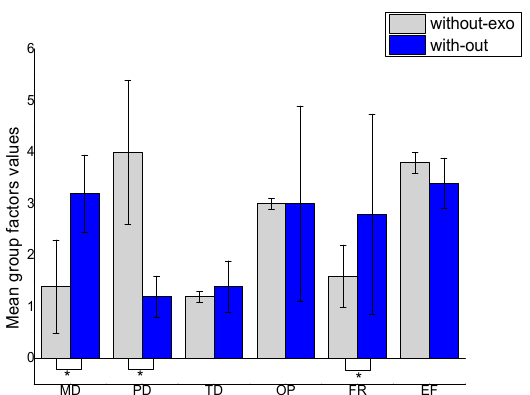
( b ) Figure 10. ( a ) The subjective discomfort performance. ( b ) The comparisons of mean rating value plots of the six workload factors. 3.5. The Weighting Factor and the Results The mean group weighting factors of the two carriage conditions were determined for the NASA TLX rating scales after the experiment, as shown in Figure 11. The results of the paired t -test illustrate that the MD and PD weights are significantly different in the two carriage conditions. The MD weight in the with-EXO condition is significantly higher ( p = 0.037) than the one which is in the conventional carriage. It means the assistive exoskeleton increases the mental demand of the subjects. According to the experiment process, the reason may be the subjects have to stabilize the human–robot system not only by providing force and torque, but by providing mental control strategies. As far as PD was concerned, the PD weight in the with-EXO condition is significantly lower ( p = 0.005) than the one in